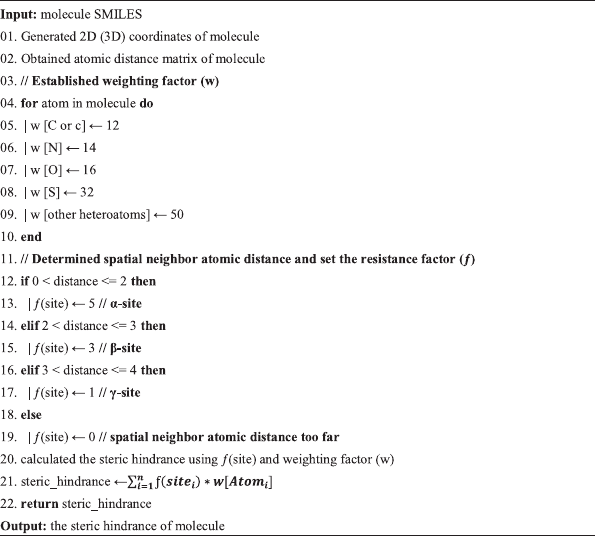
Algorithm 1 Pseudocode for calculating the steric